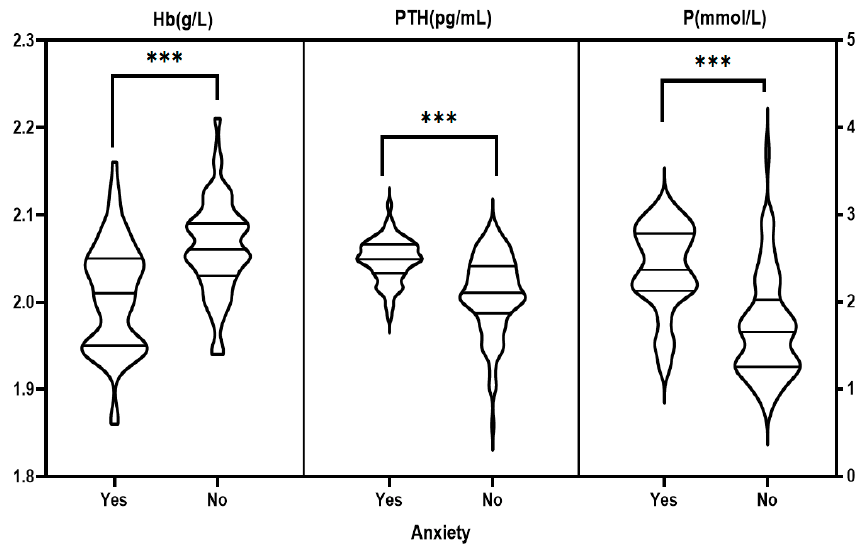
Figure 3. Single-factor analysis of anxiety in the MHD patients with laboratory tests. Note: PTH, Hb values were log-converted. *** p < 0.001.